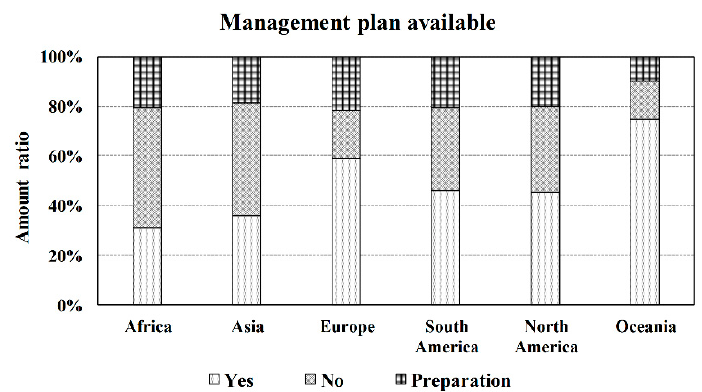
Figure 6. Amount ratio of management plan available of the Ramsar Sites in each continent. The data source of Figure 6 is the Ramsar official website. For details, see Reference